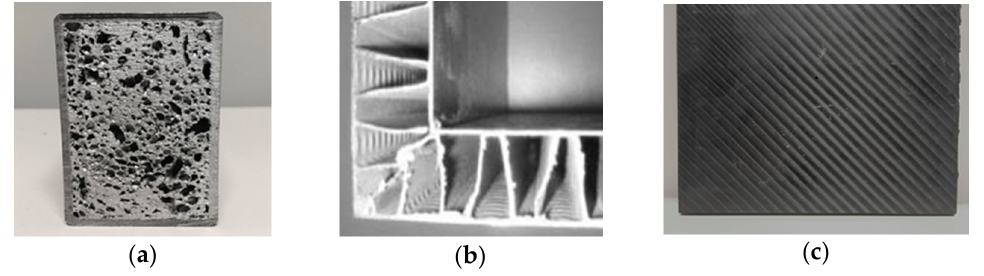
Figure 1. Lightweight MT structure materials: Al foam sandwiches (AFS) ( a ); Al corrugated-core sandwiches ( b ); and composite materials reinforced by carbon fibres (CFRP) ( c ).